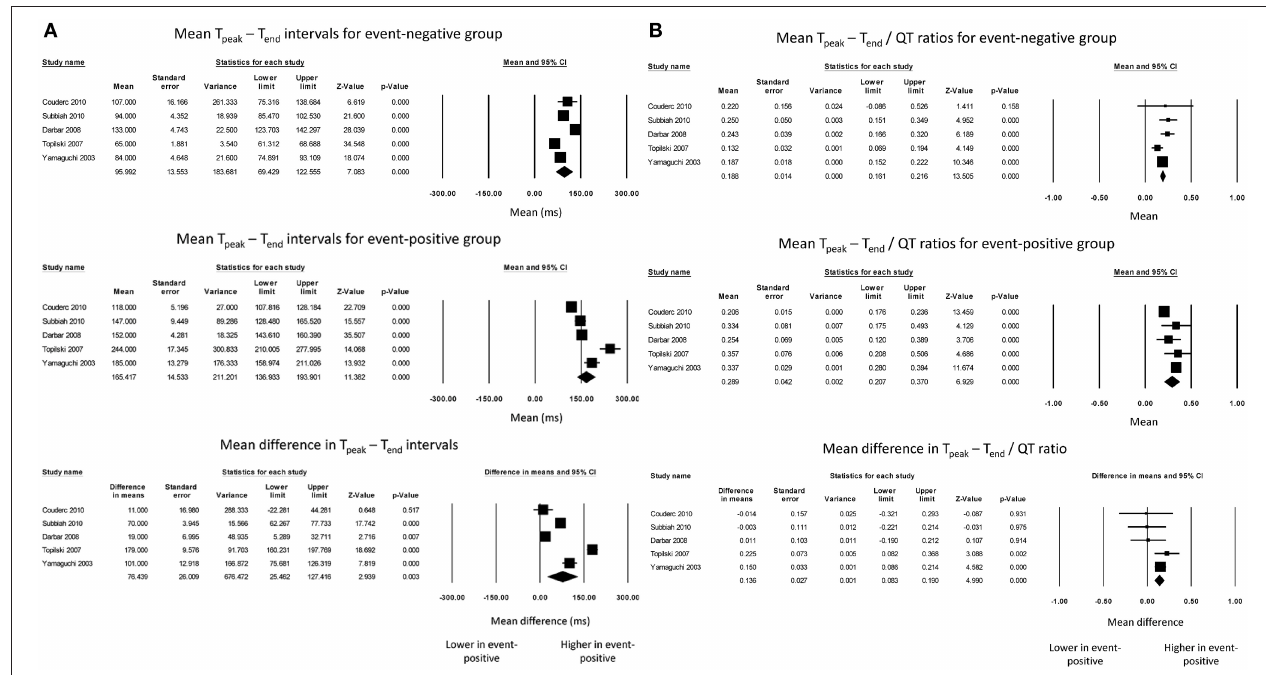
FIGURE 1 | Forest plot demonstrating the (A) mean T peak – T end intervals in the event-negative group (top panel), event-positive group (middle panel) and difference between both groups (bottom panel) in acquired QT prolongation, and (B) mean T peak – T end /QT ratios in the event-negative group (top panel), event-positive group (middle panel) and difference between both groups (bottom panel) in acquired QT